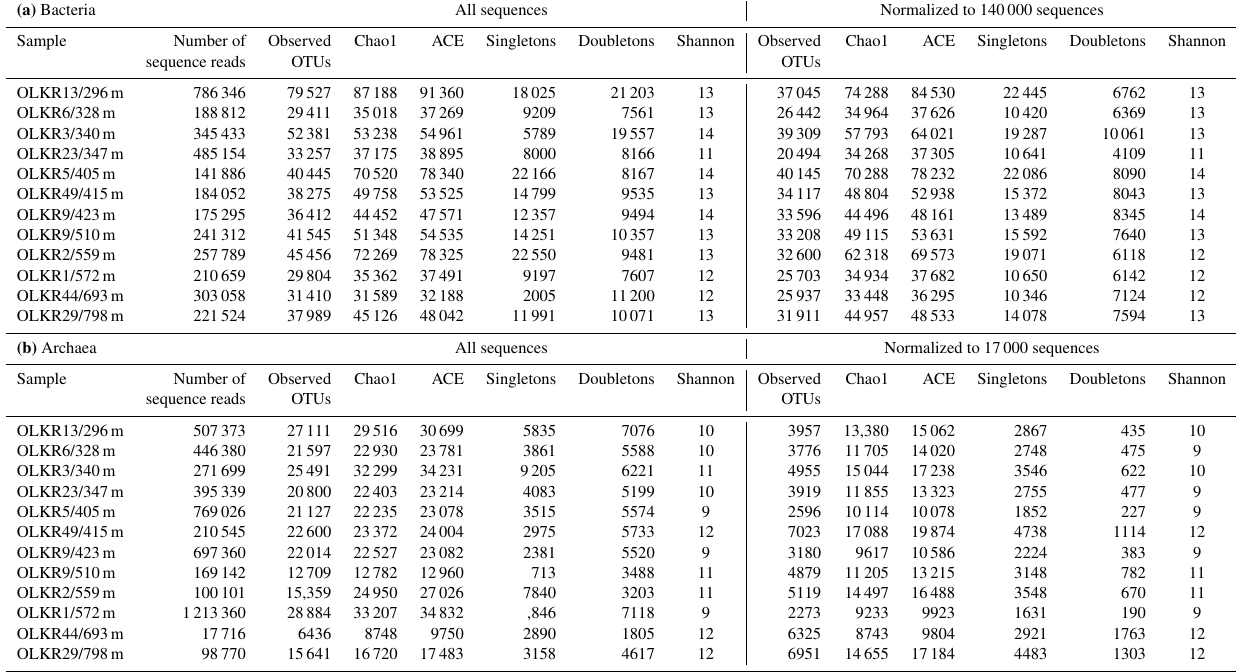
Table 2. (a) The total number of sequence reads, observed and estimated (Chao1, ACE) number of OTUs, number of singleton and doubleton OTUs, and Shannon diversity index per sample of the bacterial 16S rRNA gene data set. The analysis results are presented for both the total number of sequence reads per sample as well as for data normalized according to the sample with the lowest number of sequence reads, i.e. 140000 random sequences per sample. (b) The total number of sequence reads, observed and estimated (Chao1, ACE) number of OTUs, number of singleton and doubleton OTUs, and the Shannon diversity index per sample of the archaeal 16S rRNA gene data set. The analysis results are presented for both the total number of sequence reads per sample as well as for data normalized according to the sample with the lowest number of sequence reads, i.e. 17000 random sequences per sample.